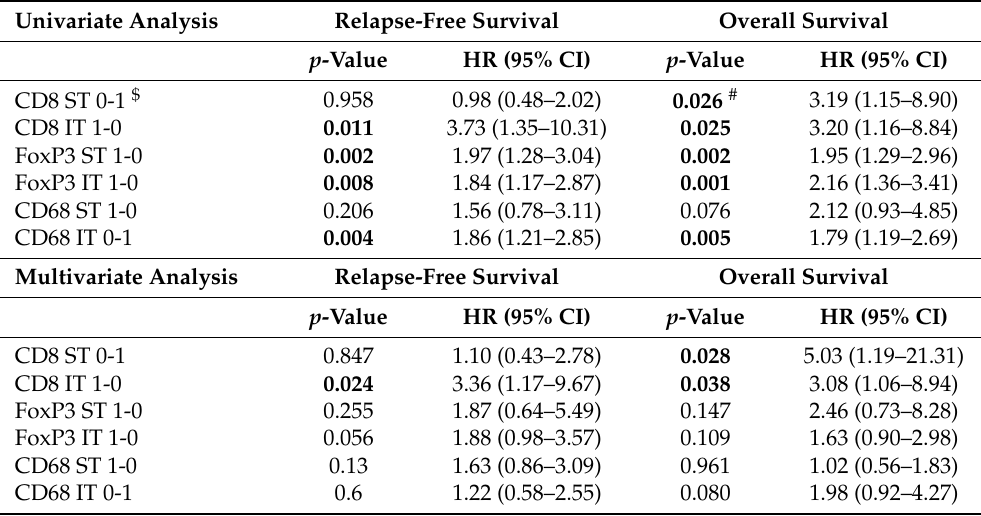
Table 2. Univariate and multivariate Cox regression models evaluating the influence of stromal (ST) or intra-tumoral (IT) of CD8, FoxP3, and CD68 on RFS and OS. Zero and one are related to the cutoff. Univariate Analysis Relapse-Free Survival Overall Survival p -Value HR (95% CI) p -Value HR (95% CI) CD8 ST 0-1 $ 0.958